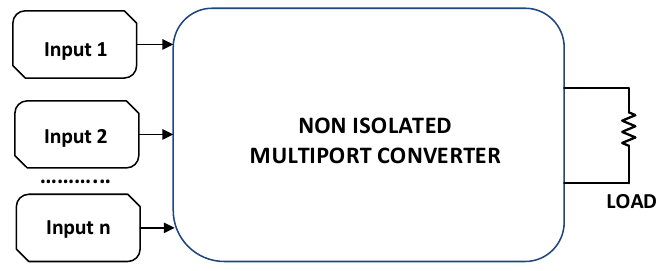
Figure 3. Structure of non-isolated n-port MPC system.